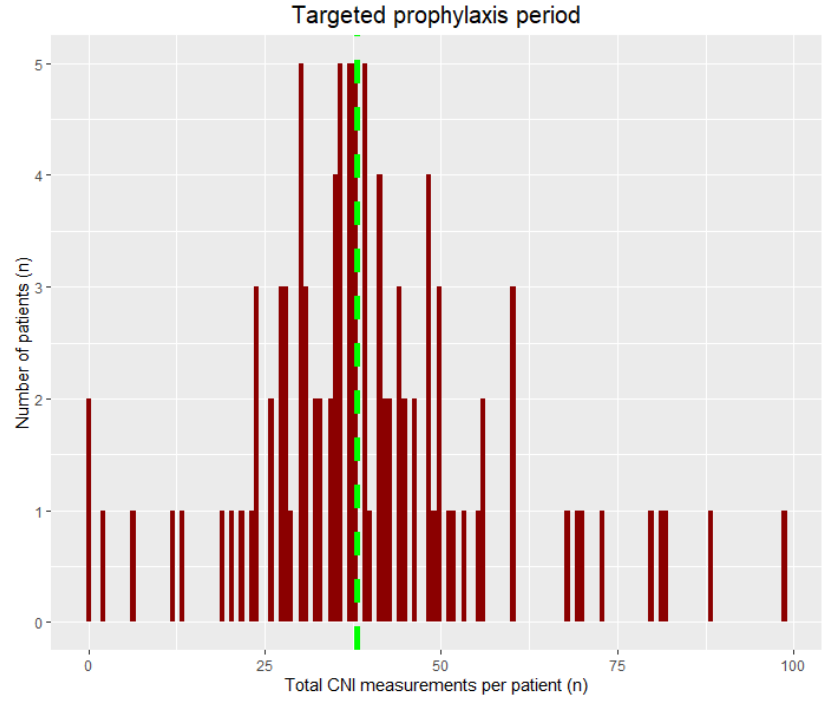
Figure A1. Total number of calcineurin-inhibitor measurements taken per patient during the first 120 days after transplantation in the universal and targeted prophylaxis period. Median number per patient indicated by dashed line, and equals 38 in both periods.